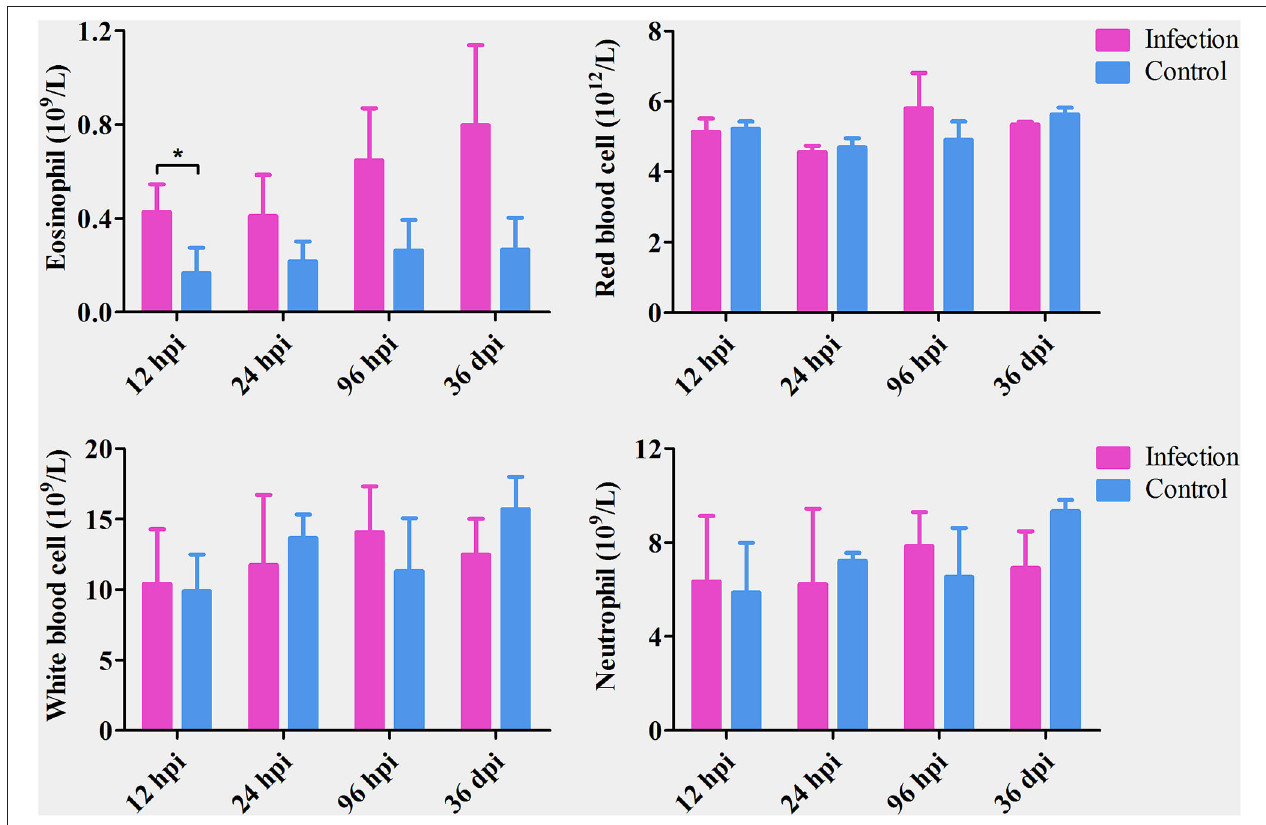
FIGURE 1 | The number of eosinophils, red blood cells, white blood cells, and neutrophils in the blood of Toxocara canis -infected (infection) and uninfected (control) groups of Beagle dogs at the indicated time points post-infection. The graphs represent the means ± standard deviations of the results obtained from three dogs per group. Statistical analysis was performed using t -test using GraphPad Prism 5 software. Asterisk denotes significance (* P < 0.05).